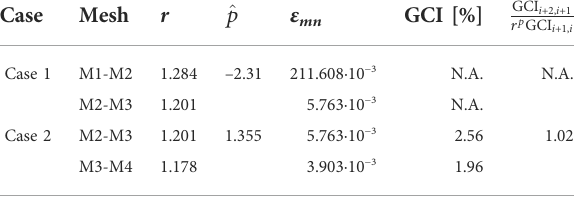
TABLE 2 Overview of GCI analysis for the standard CELL-tainer design. Case